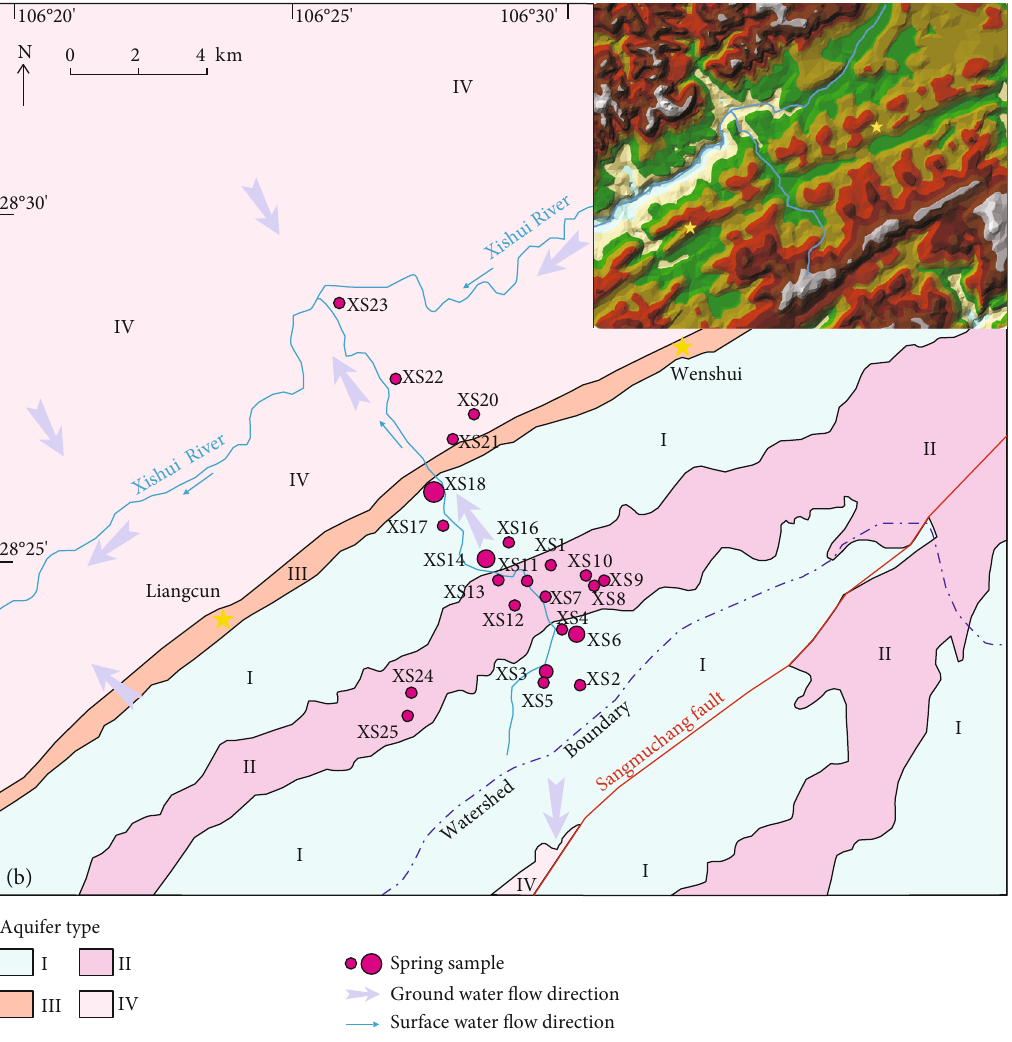
Figure 1: Study area. (a) Topography with the lowest elevation of 750ma.s.l. and the highest elevation of 1700m a.s.l.; (b) aquifer types (the introduction can be found in the text), groundwater and surface water fl ow direction, and spring sampling sites. The bigger dots indicate the spring samples with higher